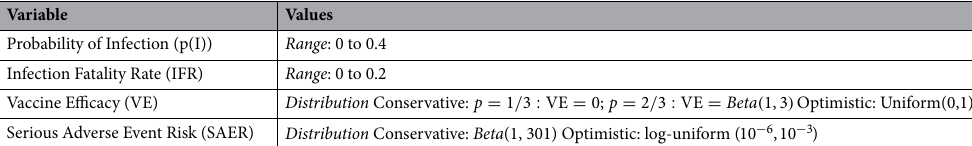
Table 1. COVID-19 vaccine emergency use modelling parameters.